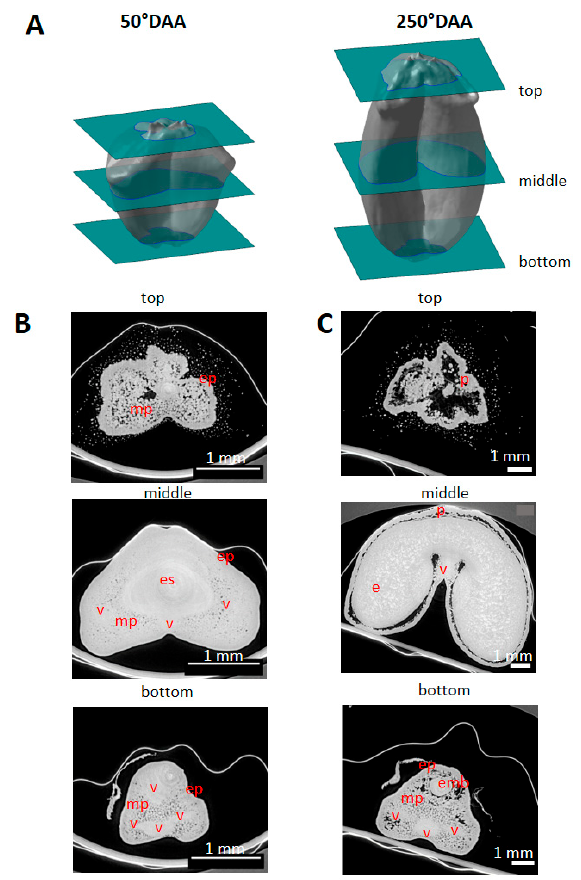
Figure 2. Spatial variability in tissue composition observed along the caryopsis longitudinal axis. ( A ) Localization of the virtual sections (green) from low-resolution X-ray µCT. ( B ) Representative image in three regions of a wheat caryopsis harvested at 50 °DAA. ( C ) Representative image in three regions of a wheat caryopsis harvested at 250 °DAA. Legends: mp—mesocarp; ep—epicarp; v— vascular tissue; e—endosperm; emb—embryo; es—embryo sac. High-resolution images of virtual cross-sections localized at different positions along the longitudinal axis of the caryopses (Figure 3A) revealed individual cells in several tis- sues (Figure 3B,C). In the pericarp, some cells of the mesocarp and endocarp (cross cells and tube cells) were distinguished due to intercellular spaces (Figure 3C). In contrast, the cells inside the embryo sac or later in the seed tissues were difficult to visually separate as there was no void between them (Figure 3B).